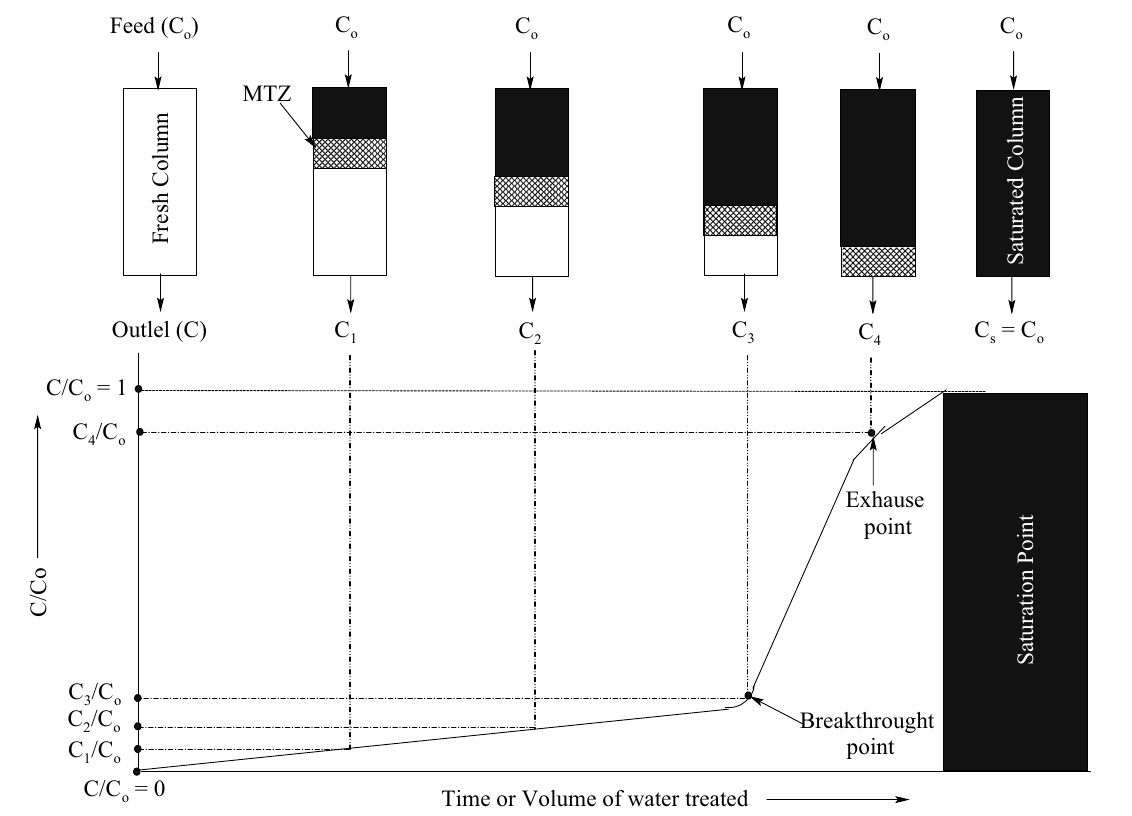
Fig. 1 Representation of breakthrough curve by movement of MTZ